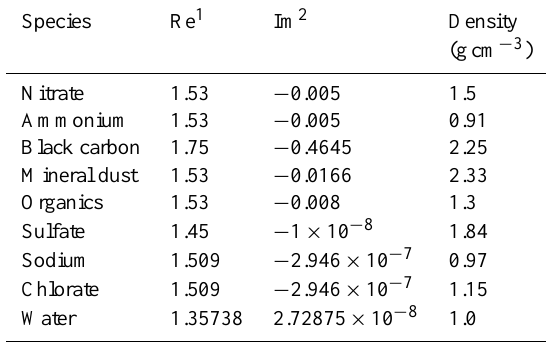
Table 1. Dry CRI and density for different aerosol species at λ